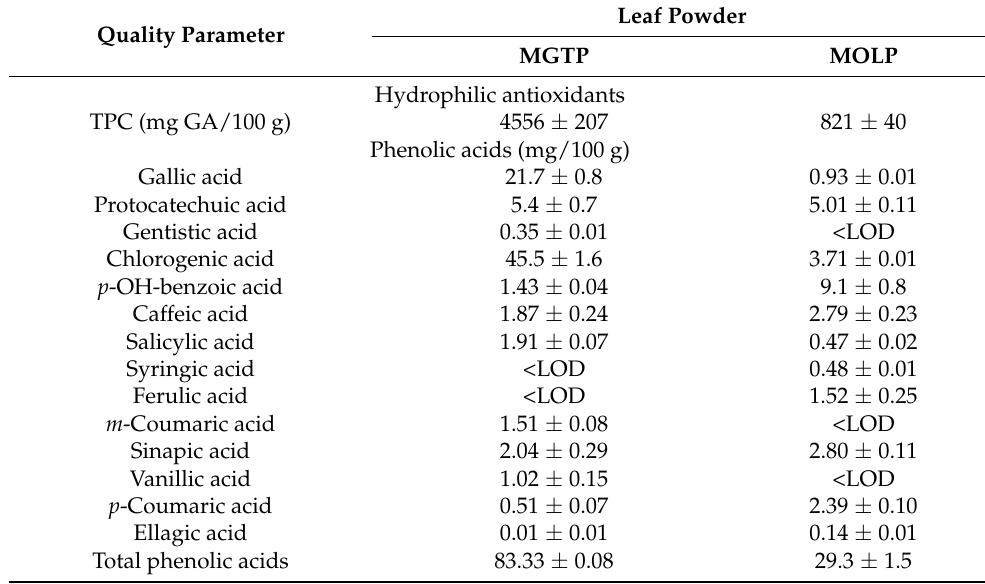
Table 1. Chemical composition and antioxidant capacity of matcha green tea powder and moringa leaf